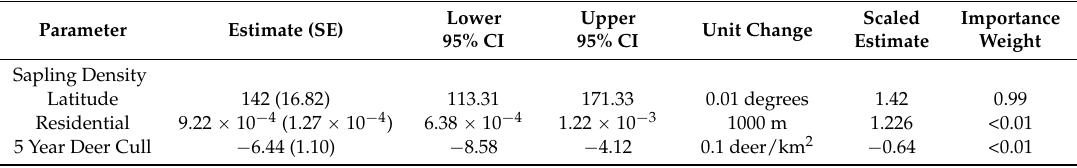
Table 3. Modeled parameter estimates, standard errors (SE), associated upper lower 95% confidence intervals (Cl) for the best fitting linear regression models of predicting sapling density. Unit change was based on type of